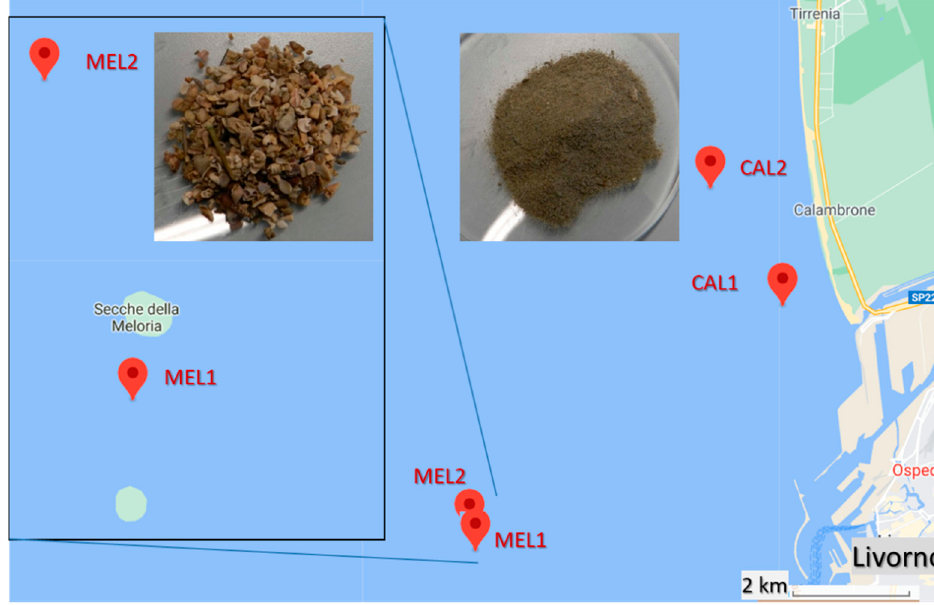
Figure 1. Sampling sites and morphology of the two types of sediment sample: CAL and